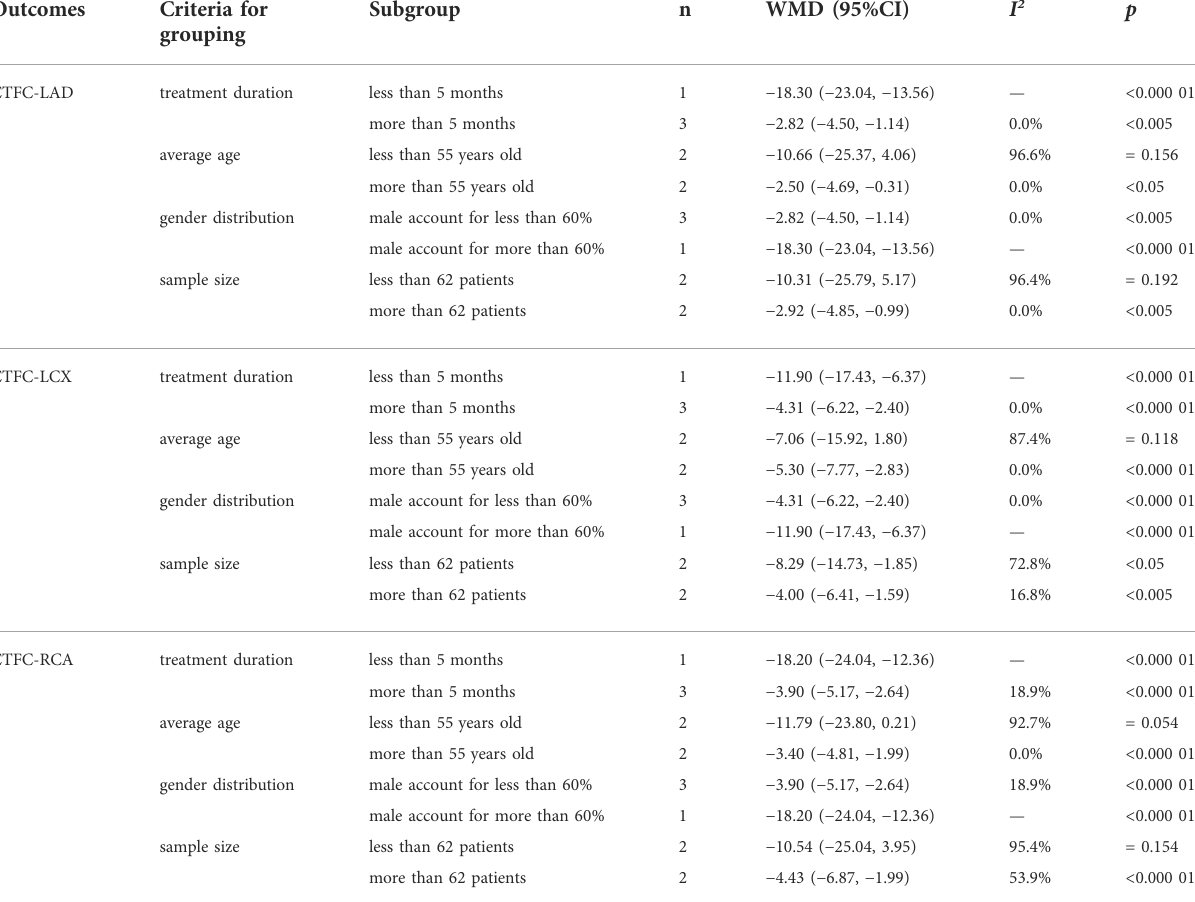
TABLE2 Subgroup analysis ofCTFC-LAD,CTFC-LCX,andCTFC-RCAbasedontreatmentduration,averageage, genderdistribution,andsamplesize.